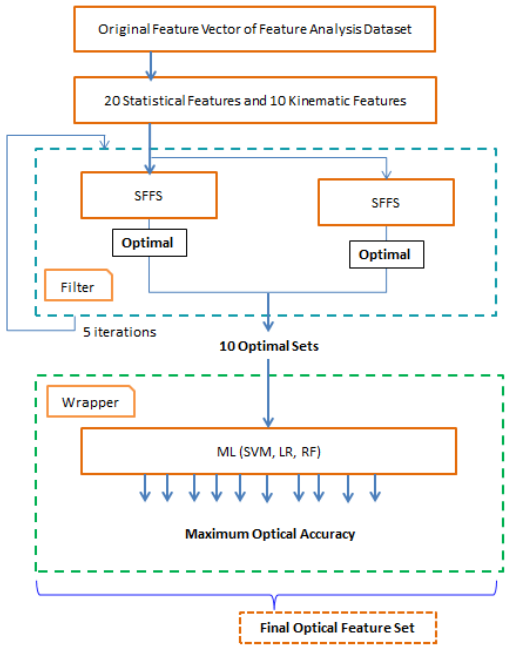
Figure 6. Block diagram of the optimal feature selection process.